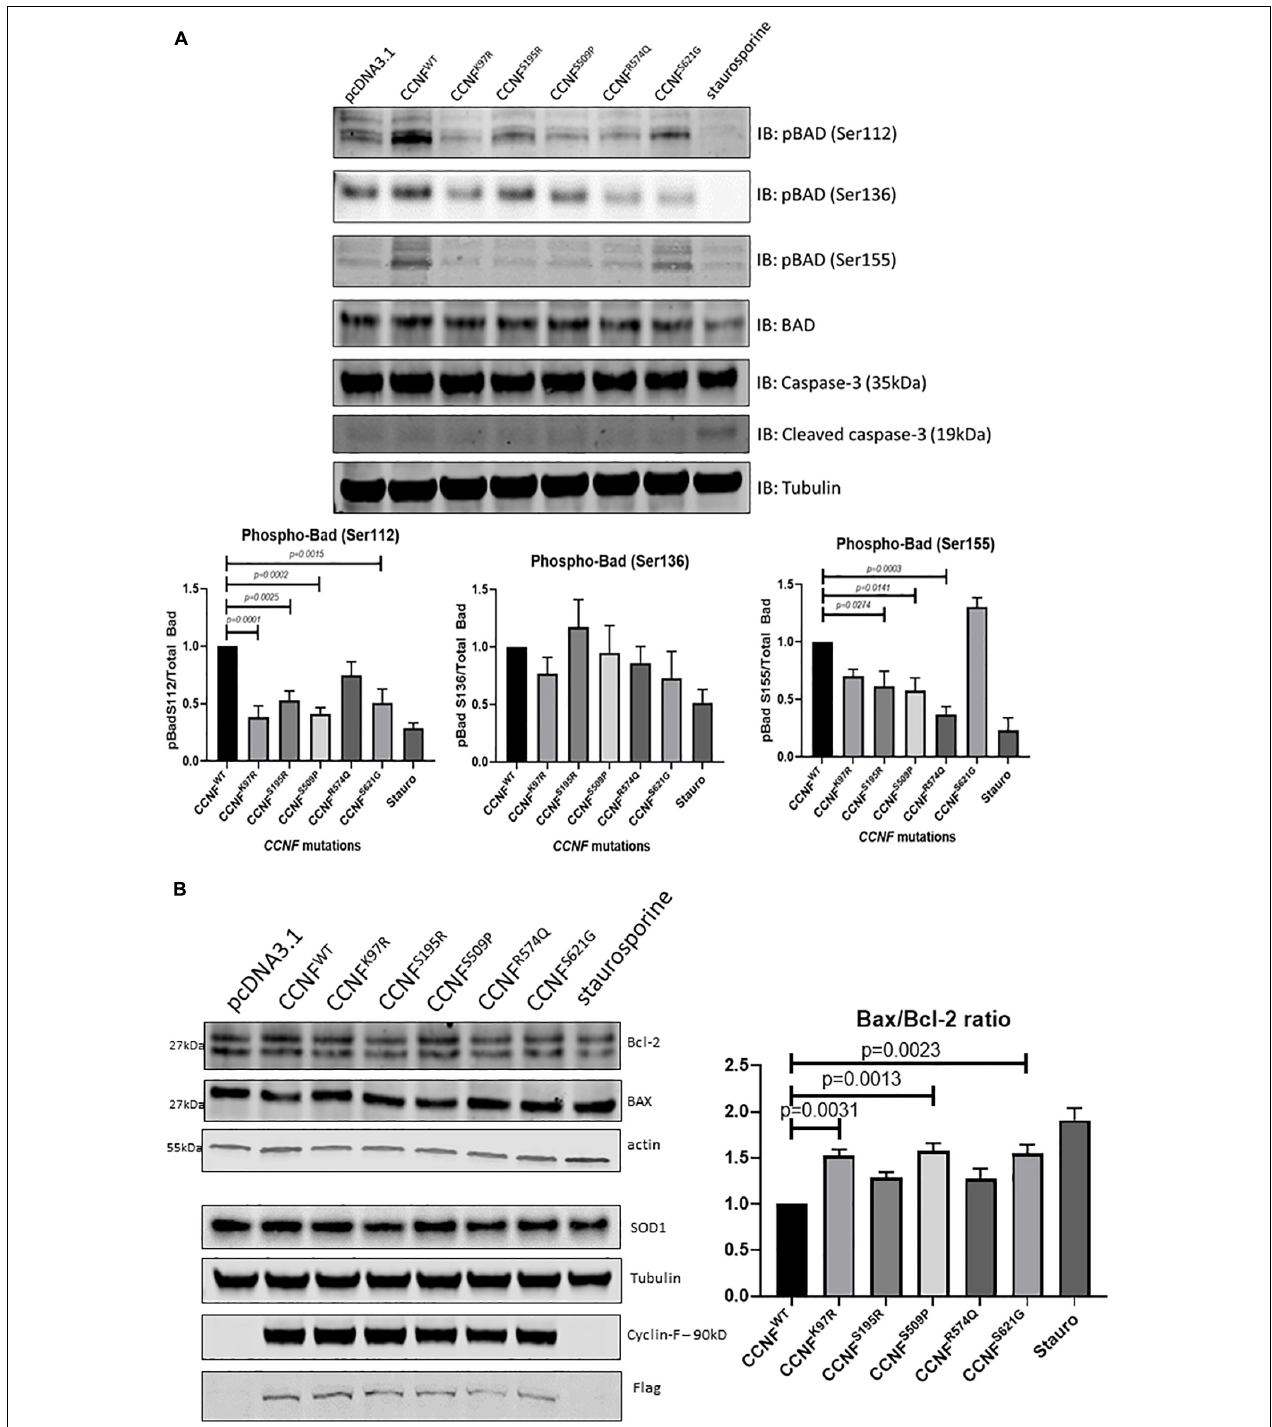
FIGURE 4 | (A) Phosphorylation of Bcl-2 associated agonist of cell death (Bad) at Ser112, Ser136, and Ser155 reveals activation of the intrinsic apoptosis pathway. pBad (Ser112) was decreased in the cyclin F variants K97R (0.385-fold, p = 0.0001, n = 4), S195R (0.529-fold), S509P (0.413-fold), and S621G (0.508-fold) when compared to the cyclin F wild-type control (one-way ANOVA with Dunnett’s multiple comparison test, n = 4). pBad (Ser155) was decreased in only S195R (0.616-fold), S509 (0.578-fold), and R574Q (0.37-fold) when compared to the cyclin F wild-type control (one-way ANOVA with Dunnett’s multiple comparison test, n = 4). (B) Immunoblot analysis of Bcl-2, Bax, and SOD1 from cells expressing cyclin F wild-type and variants (K97R, S195R, S509P, R574Q, S621G) reveals increased Bax/Bcl-2 ratios in K97R (1.53-fold), S509P (1.58-fold), and S621G (1.55-fold) (one-way ANOVA with Dunnet’s multiple comparison test, n = 3) suggesting increased stimulation of